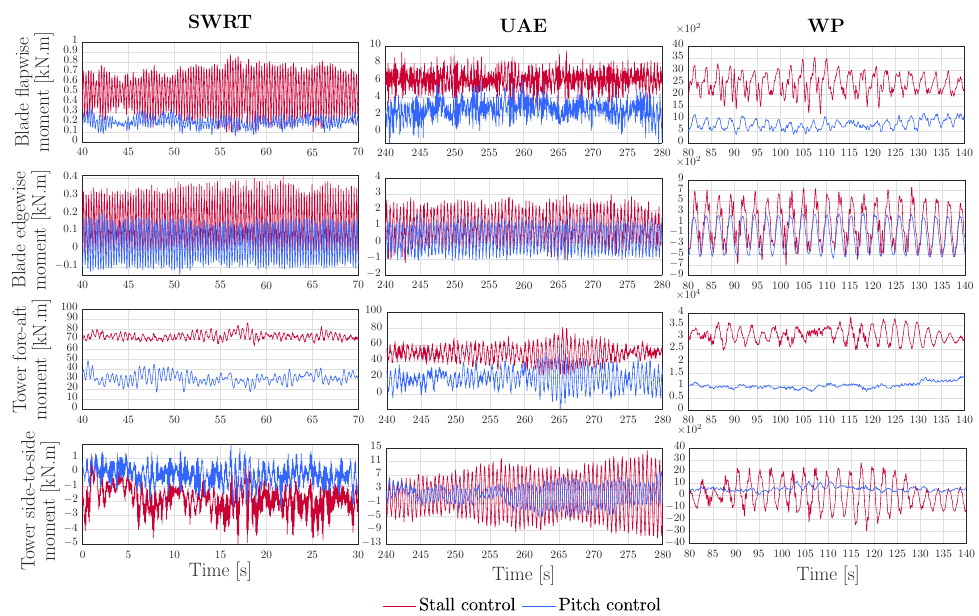
Figure 11. Comparison of the structural bending moments of the SWRT, UAE, and WP wind turbines in turbulent